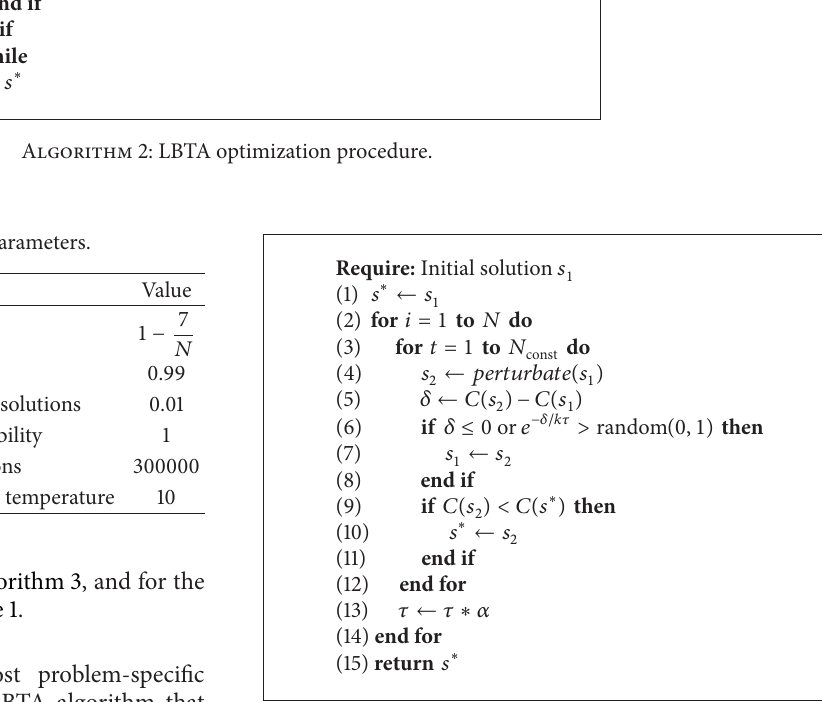
Algorithm 3: Simulated